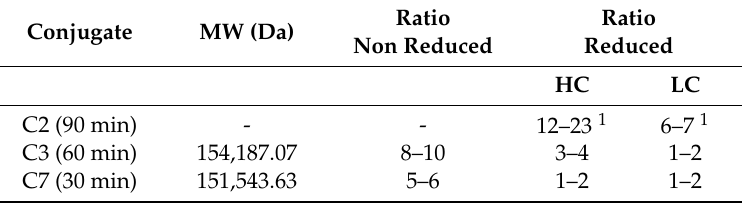
Table 1. Average of DOTA(SCN) molecules per molecule of cG250 by mass spectrometry. Ratio Conjugate MW (Da) Non Reduced